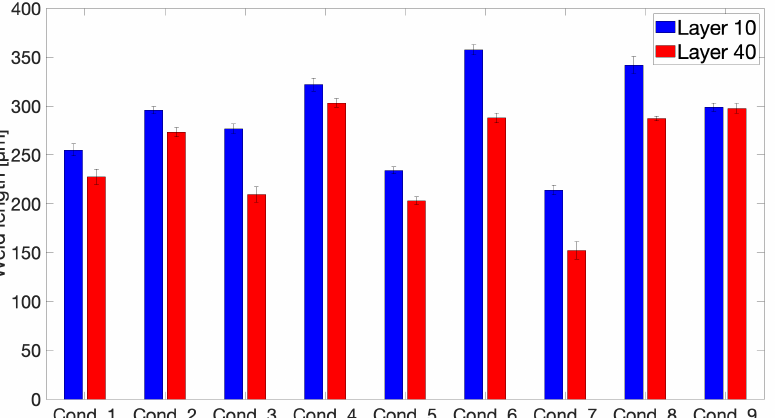
Figure A10. An overview across all printing conditions of the average weld length for each respective interlayer interface measured from microscopy